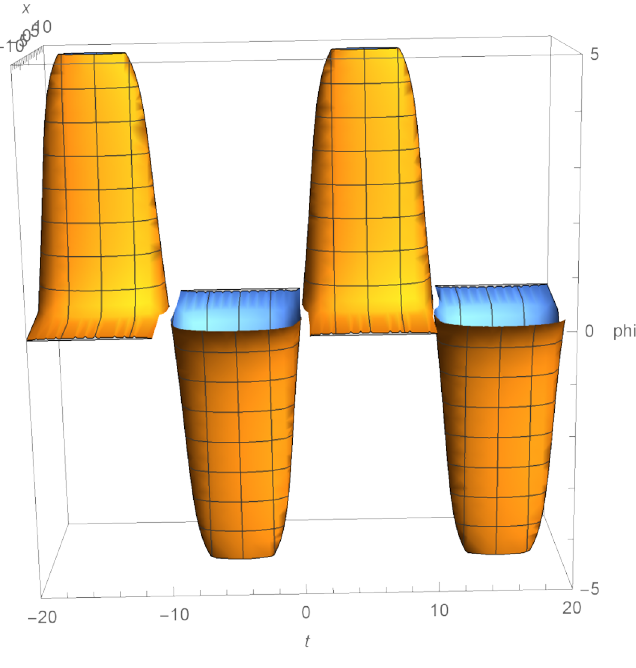
Figure 9 . The breather solution for µ = 1 , β = 1 , tan ψ = 2 π/ 5 , λ = 1 / 10